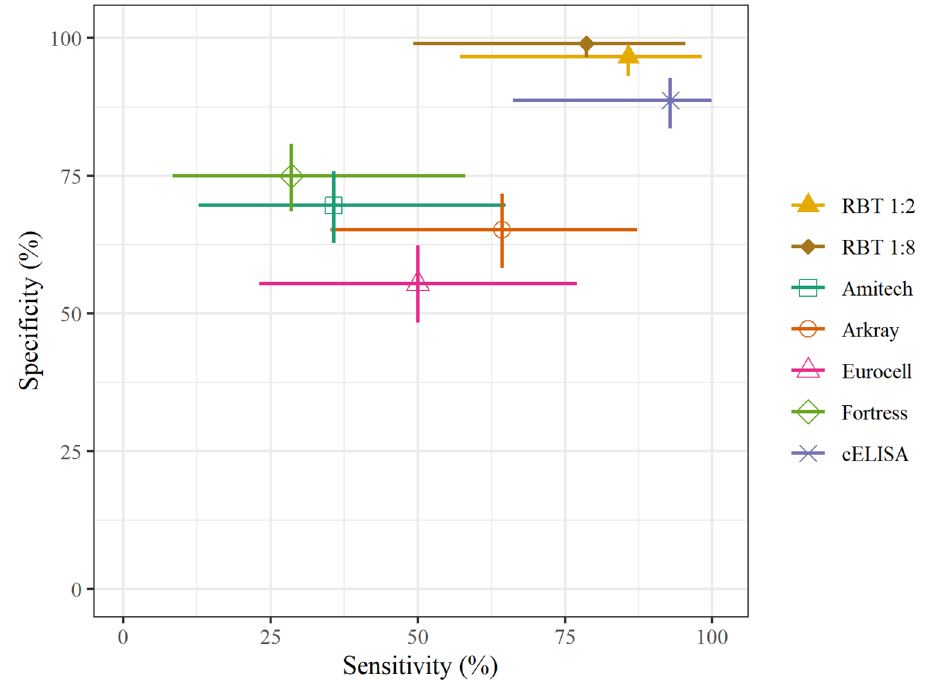
Figure 1. Point estimates of the sensitivity and specificity with 95% confidence intervals (horizontal and vertical lines) for each index test (n = 218). RBT: the Rose Bengal test. cELISA: competitive enzyme-linked immunosorbent assay.